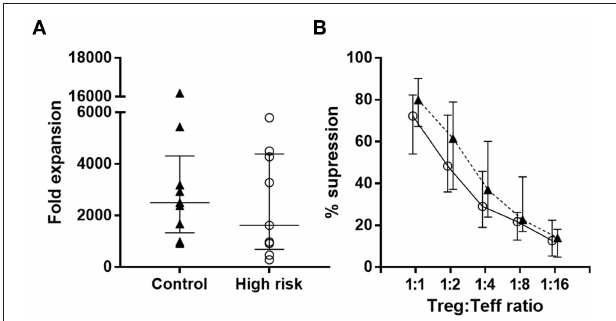
FIGURE 5 | Treg expansion and function. (A) Fold expansion of Treg from high-risk individuals ( n = 9, white circles) and controls ( n = 9, black triangles) after 2 weeks expansion. Dots represent individual samples. Error bars show median ± interquartile range (B) Suppression exerted by Tregs on autologous Teff from high-risk individuals (white circles) and controls (black triangles) at different Treg/Teff ratios. Data are presented as median ± interquartile range. p -values for differences between groups were determined using Mann-Whitney U-test. No significant differences were